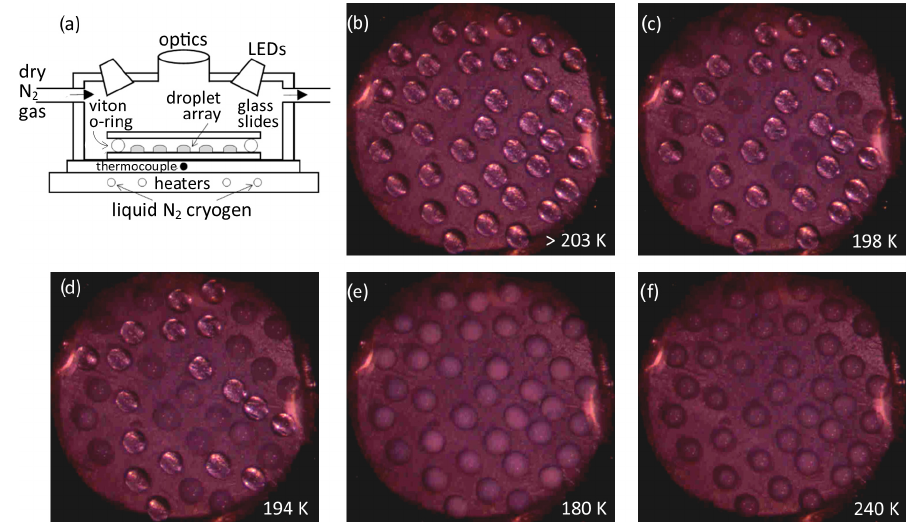
Figure 2. (a) Diagram showing experimental apparatus. An aluminium stage is cooled by a constant flow of liquid nitrogen and temperature and the rate of change is controlled by heating cartridges embedded in the aluminium. A hydrophobic glass slide is placed on this surface, arrays of 1µL droplets are pipetted onto the slide, surrounded by a greased Viton o-ring and covered with a second slide to minimise concentration change by mass transfer between liquid and vapour. A dry nitrogen flow is passed over this sealed cell to prevent ice deposition from the atmosphere at low temperature. The cell is lit using plane polarised LEDs and reflected light images recorded with a microscope equipped with a CCD camera. (b–e) droplet arrays showing nucleation and crystal growth on cooling, (f) partially melted array on